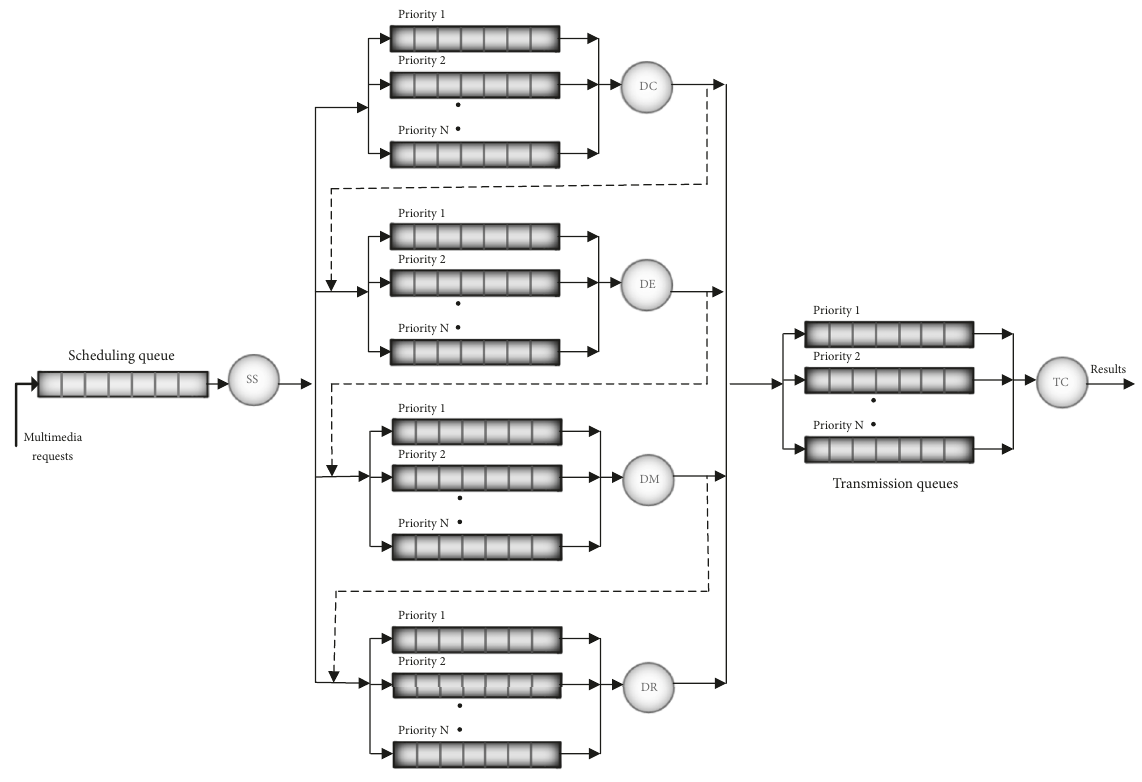
Figure 3: Priority-based queuing model for multimedia cloud computing